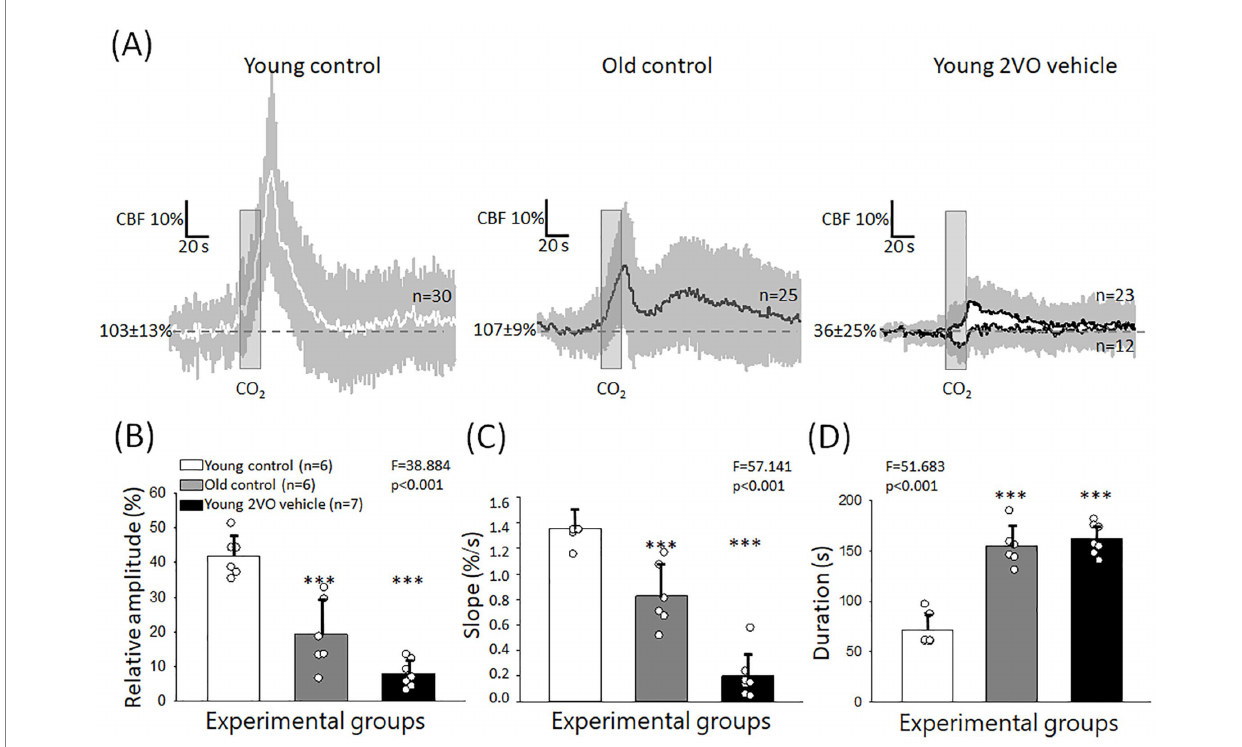
FIGURE 3 Hypercapnic vasodilation impaired by age and acute cerebral ischemia. (A) Mean traces (±stdev) of CBF changes with individual hypercapnic trials in the Young control, Old control and young acute cerebral ischemia (Young 2VO vehicle) groups. (B) The relative amplitude of hyperemia in response to hypercapnia. (C) The rate of hyperemia (rising slope). (D) The duration of hyperemia. In B-D , data are given as mean ± stdev. The normal distribution of data was evaluated with a Shapiro–Wilk test ( B : p = 0.694, C : p = 0.058, D : p = 0.149). In B–D , one-way ANOVA was applied, followed by a Holm